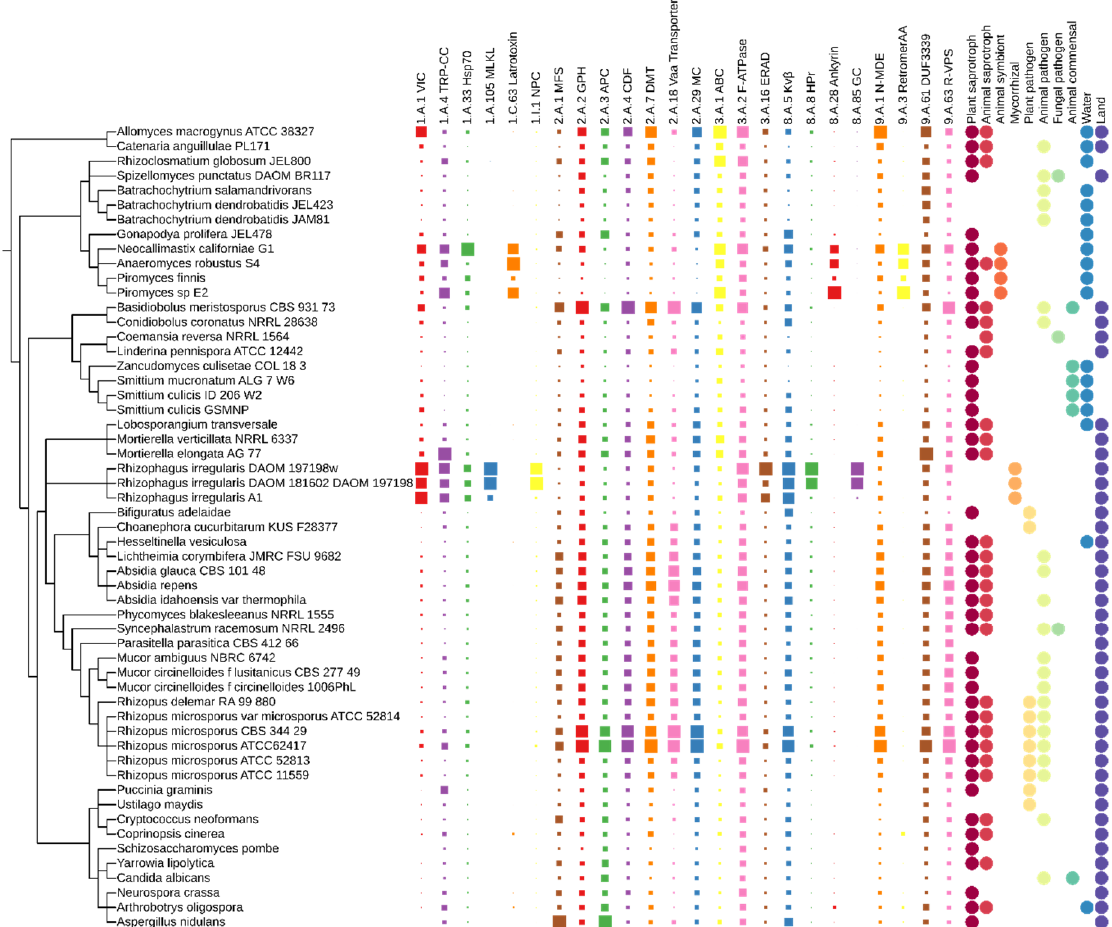
Figure 3. Distribution of adaptasome transporters within early-diverging fungi. The presence of proteins belonging to a particular family is marked with squares of size corresponding to their copy number. Fungal ecology features are shown as circles.